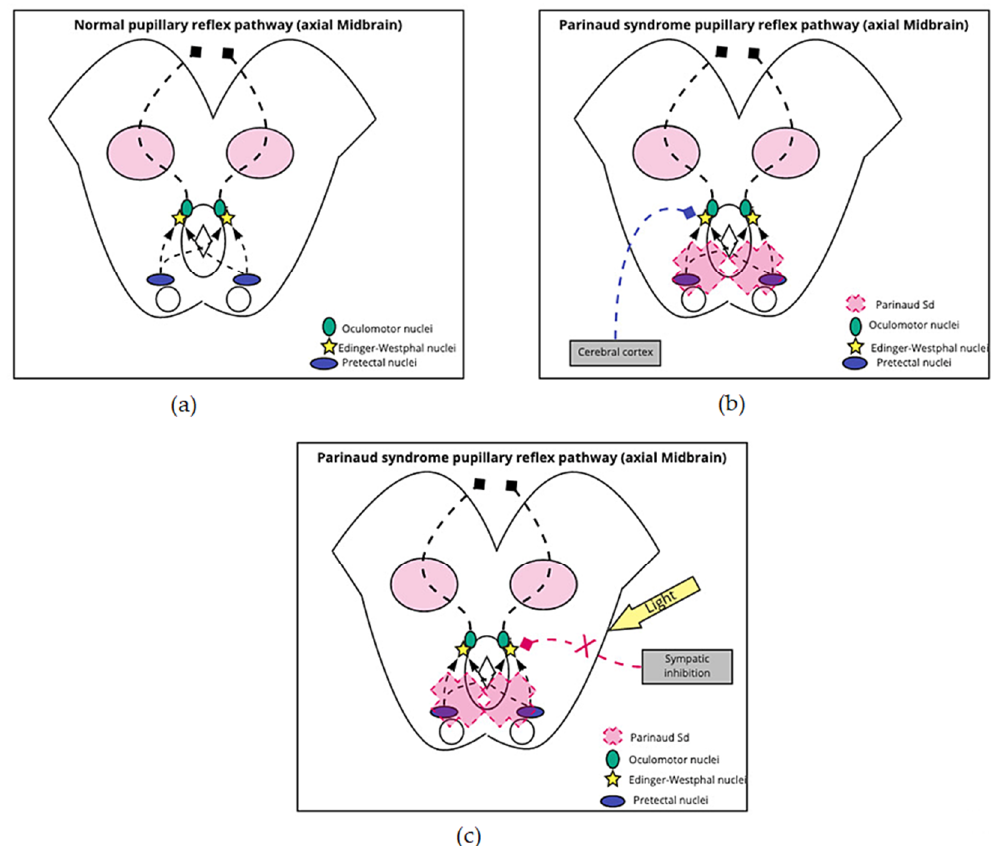
Figure 2. Pseudo-Argyll Robertson Pupils. ( a ) Normal reflex: Signals from the optic nerve enter the pupillary reflex pathway through the pretectal nuclei, which are located anterior to the superior colliculi. The information advances bilaterally to both Edinger–Westphal nuclei, from which exit the parasympathetic fibers that accompany the NC III on its way to the eyeball; ( b , c ) Parinaud’s syndrome reflex: The syndrome generates damage to the pretectal nuclei, which prevents signals from reaching the Edinger–Westphal nuclei. To ensure signal arrival to these nuclei and activation of pupillary contraction, the pretectal nuclei can be bypassed and go directly from the cortex; the other possible mechanism is the antagonistic action of light on the sympathetic inhibition of the Edinger–Westphal nuclei.